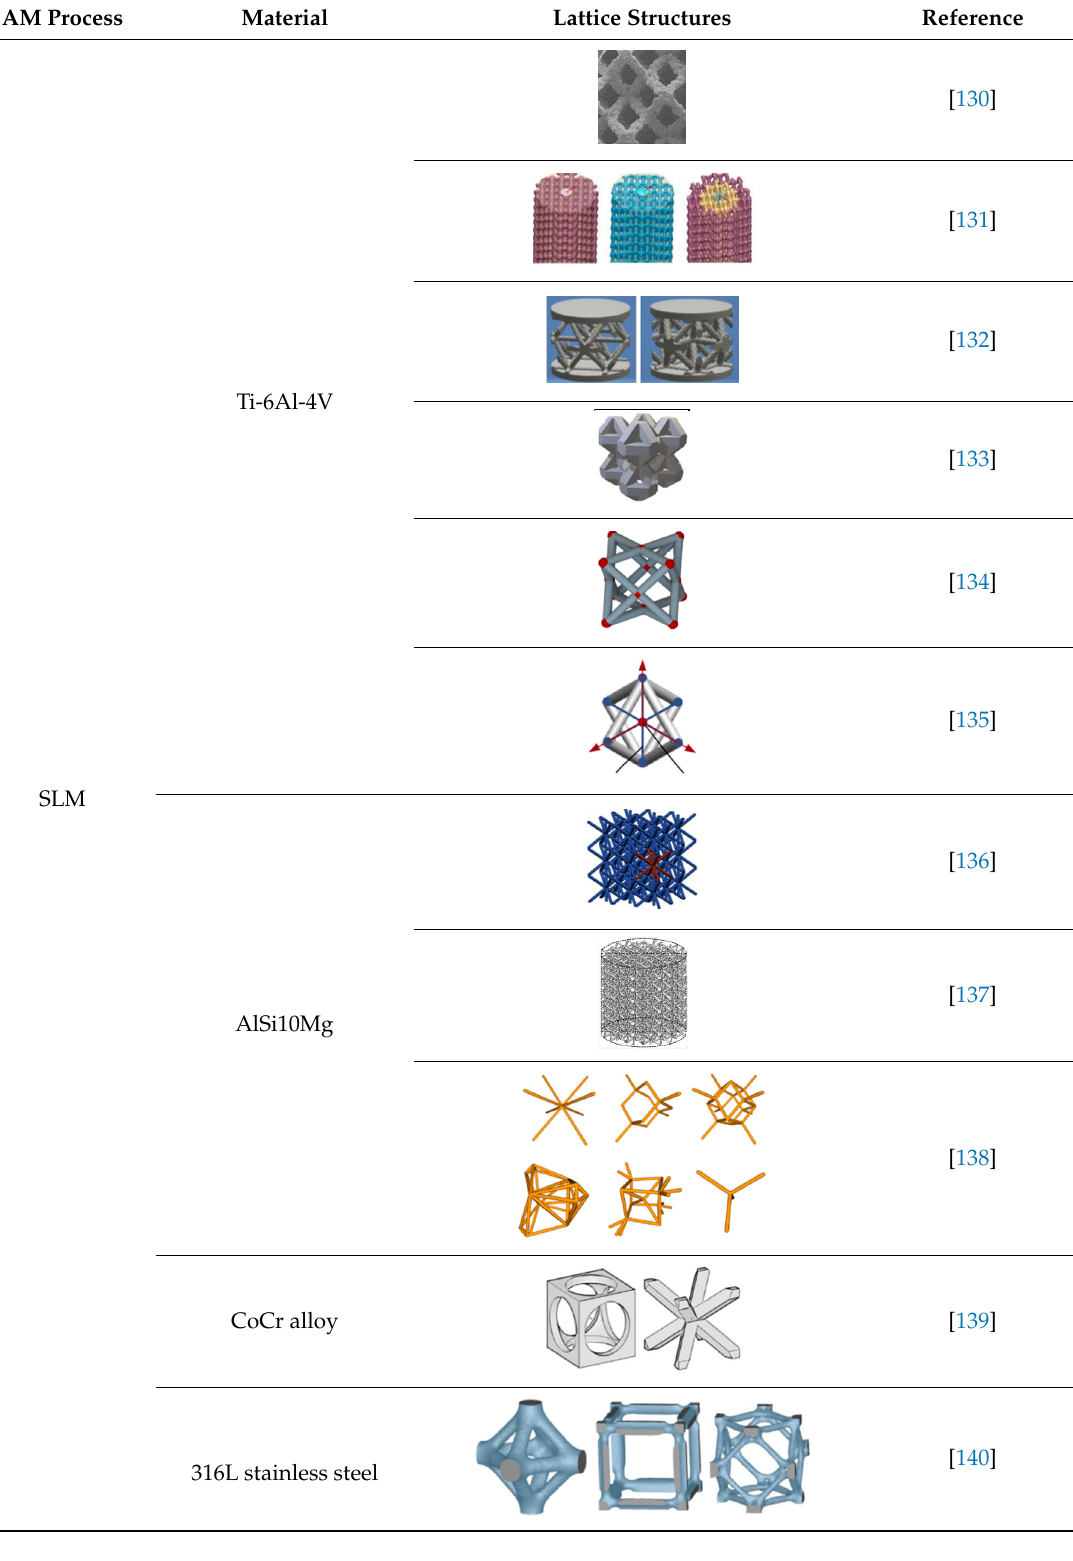
Table 2. A summary of lattice structures fabricated by AM.